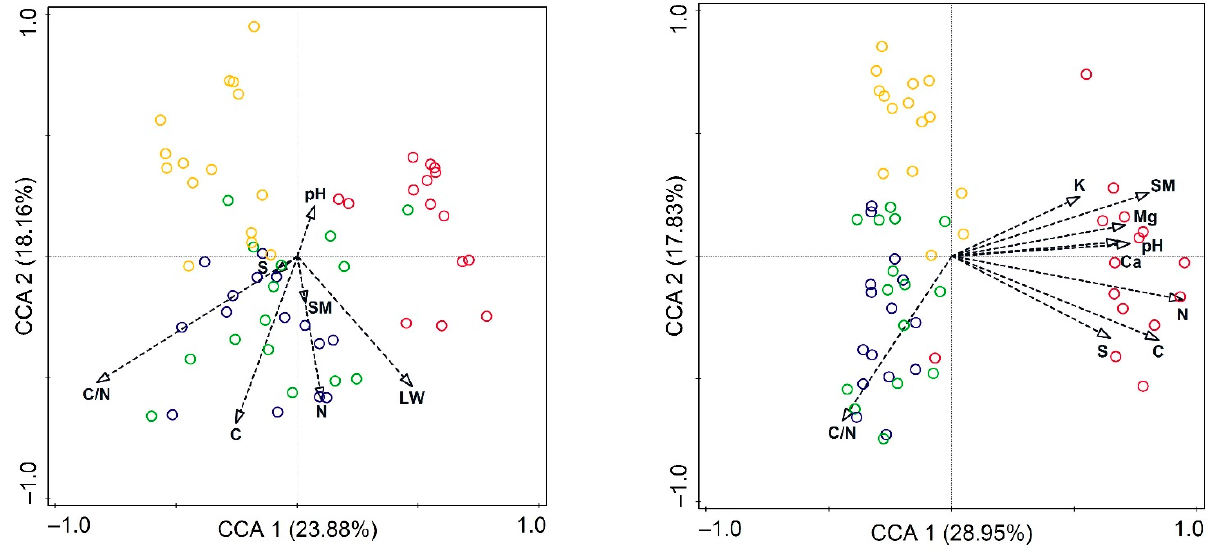
Figure 1. Canonical correspondence analysis for physico-chemical soil properties and different forest stands within the O-horizon ( left ) and the A-horizon ( right ). Arrows represent the direction of the steepest increase of individual physico-chemical properties. Circles represent individual sampling sites, with color distinctions of dominant tree species in the stands (blue— Pseudotsuga menziesii ; green— Picea abies ; yellow— Fagus sylvatica ; red— Acer pseudoplatanus ).